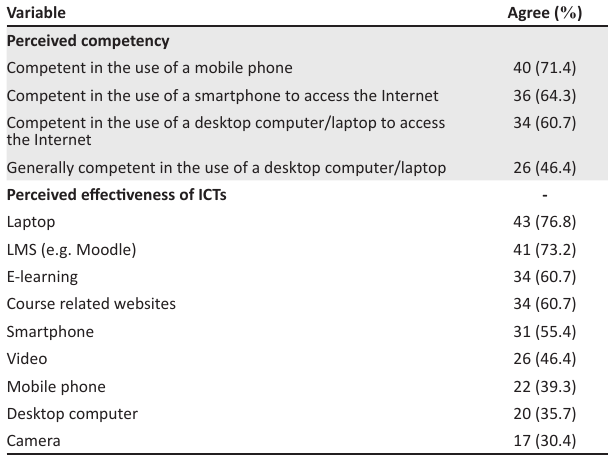
TABLE 3: Institutional environment ( N = 56). TABLE 4: Individual characteristics ( N =